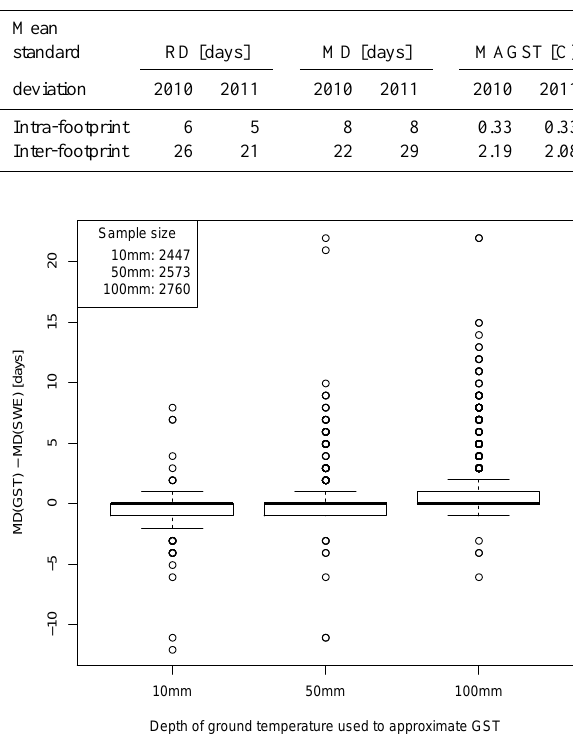
Table 2. Standard deviations of the intra-footprint and inter- footprint scale.